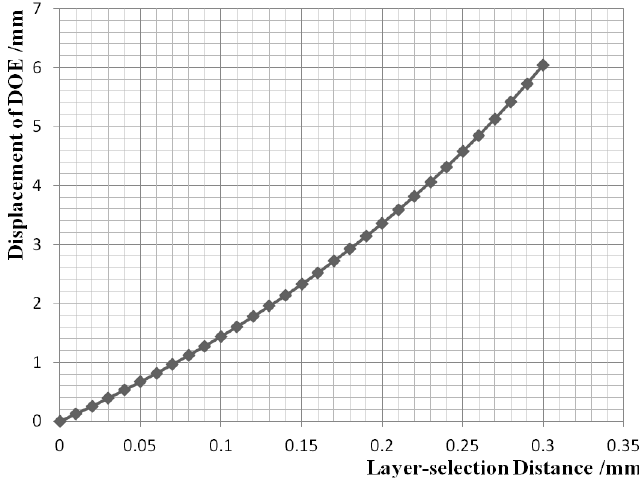
Figure 9. Layer-selection distance versus displacement of